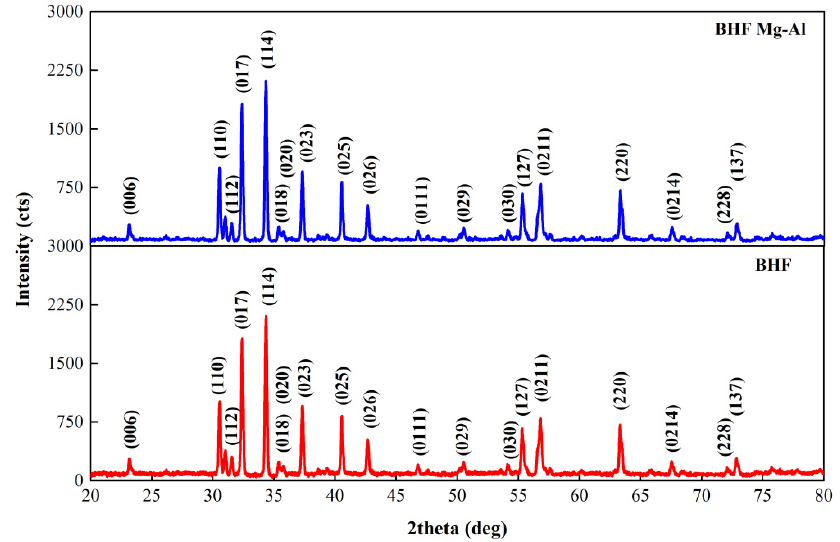
Figure 2. X-ray diffraction pattern of BHF and Mg-Al doped BHF.